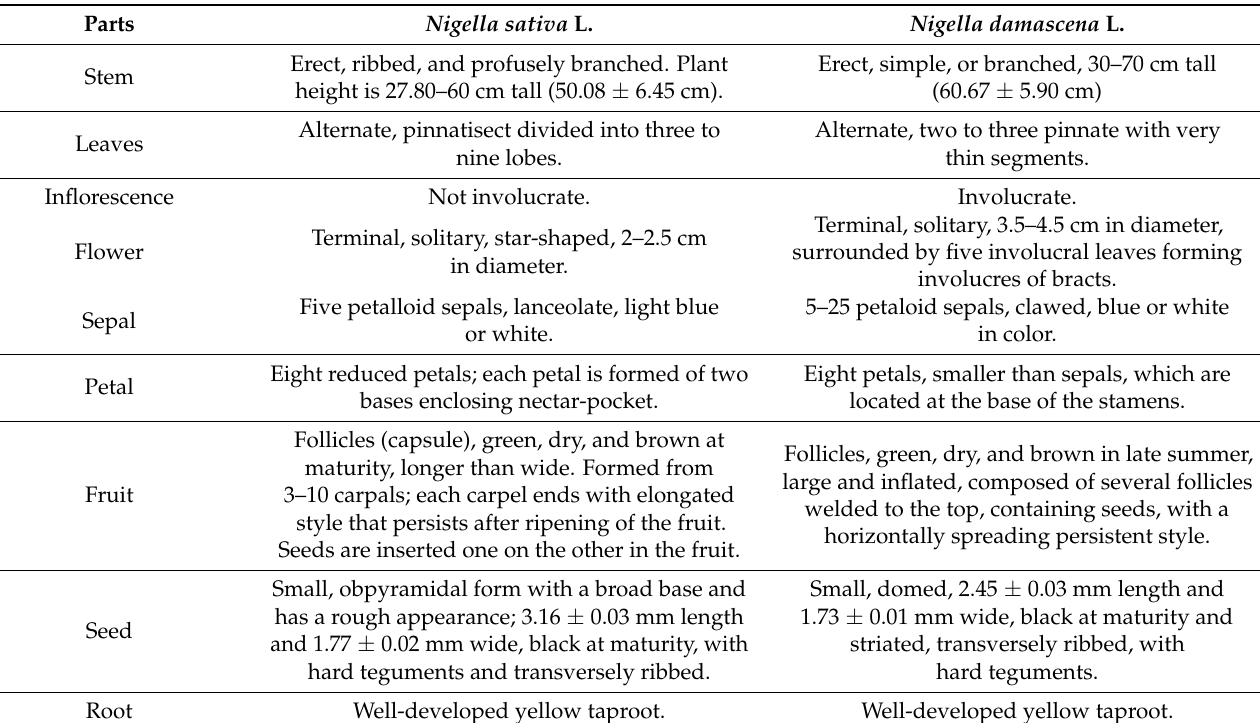
Table 1. Morphological characters of Nigella sativa L. and Nigella damascena L. seeds. Nigella sativa